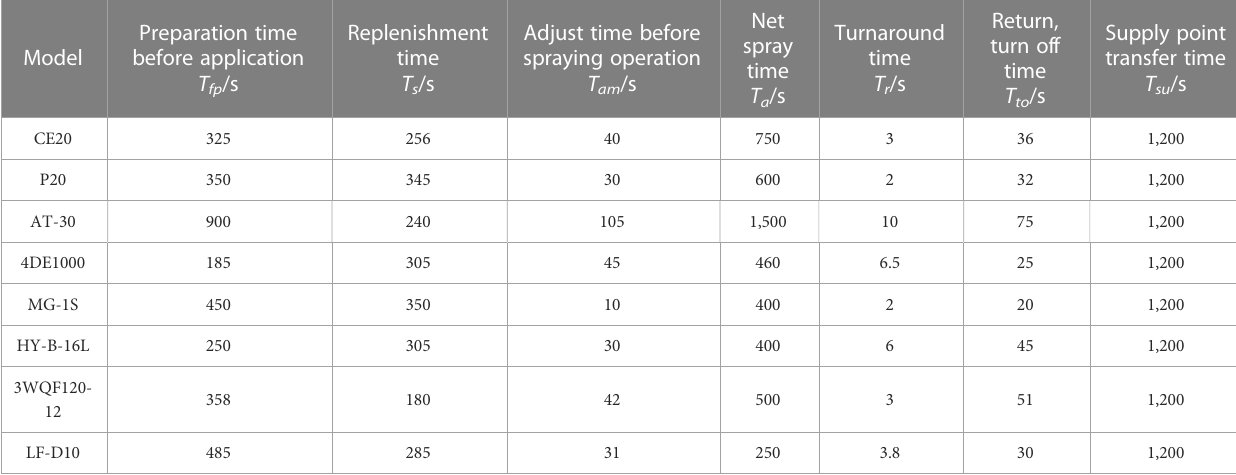
TABLE 1 1 Time composition test data for each unit.